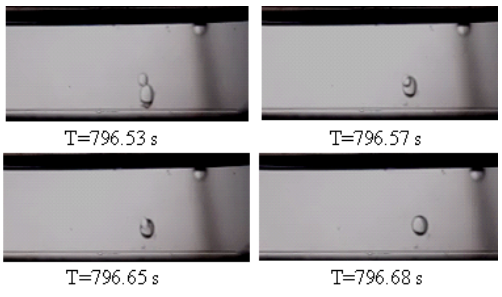
Figure 14. The first type of droplet coalescence (Ca E = 0 . Fig14. The first type of droplet coalescence (Ca